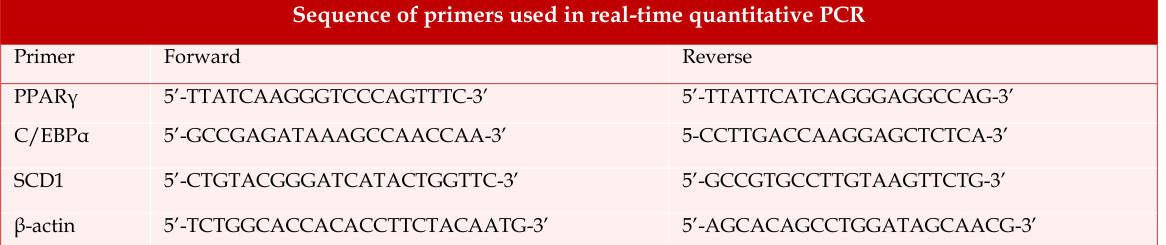
Sequence of primers used in real-time quantitative PCR